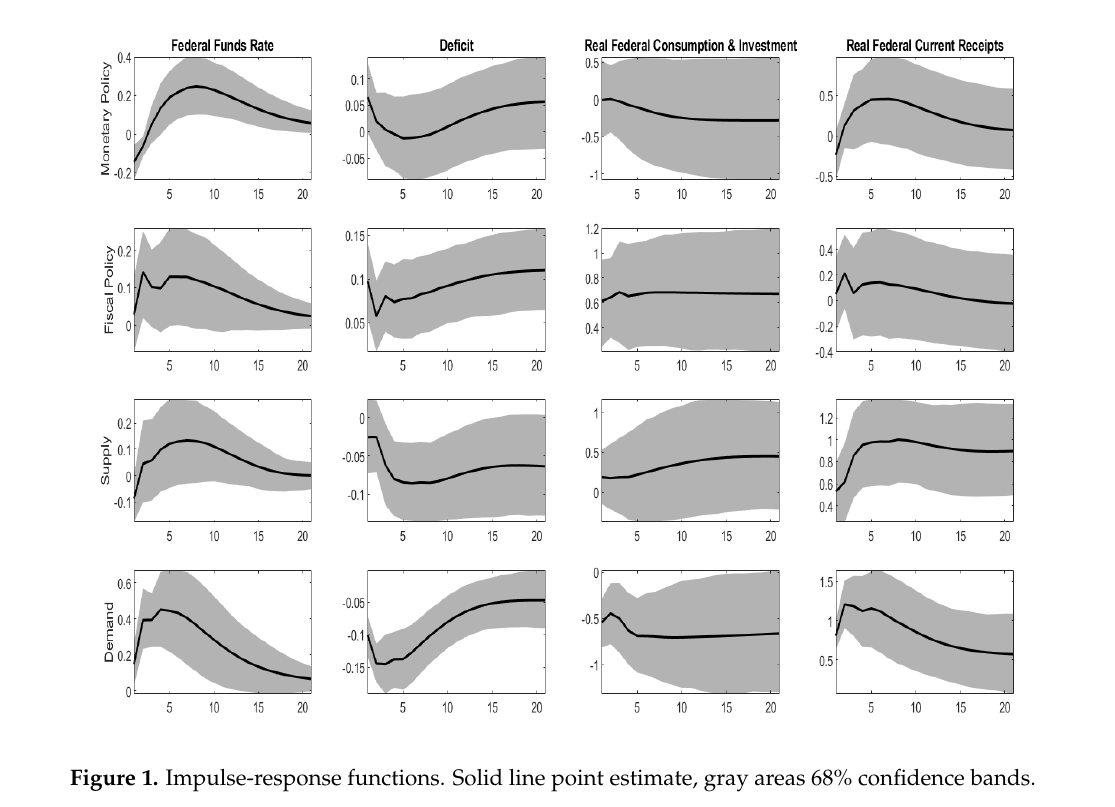
Figure 1. Impulse-response functions. Solid line point estimate, gray areas 68% confidence bands.